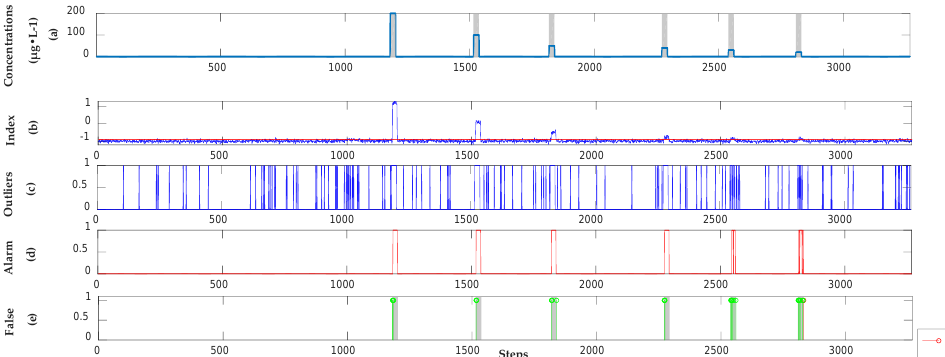
Figure 4. The detection results of phenol in the semi-supervised model. ( a ) Location and concentration of each event; ( b ) Alarm signals, which exceeded the threshold shown as the red dotted line; ( c ) Outliers obtained by using SVR; ( d ) Alarm sequences triggered by Sequential Bayesian; ( e ) False positive (FP) points and False negative (FN) points compare with real categories.